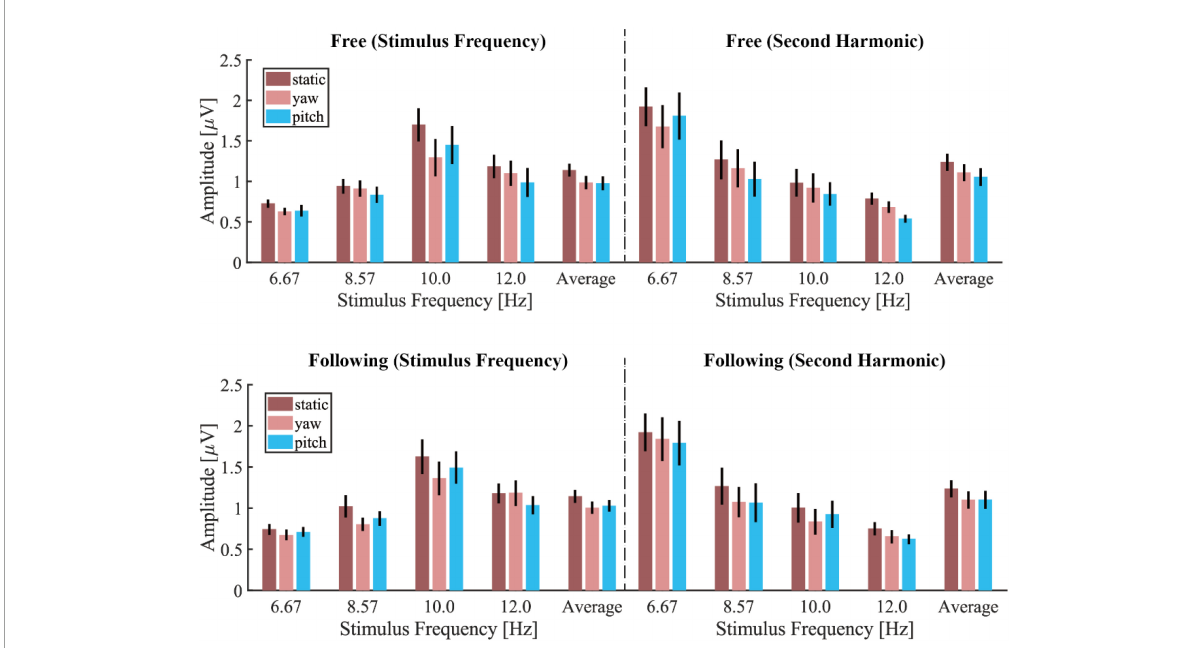
FIGURE5 The mean and standard error of the mean (SEM) of spectrum amplitude corresponding to the stimulus frequency and its second harmonic in different moving tasks and patterns.